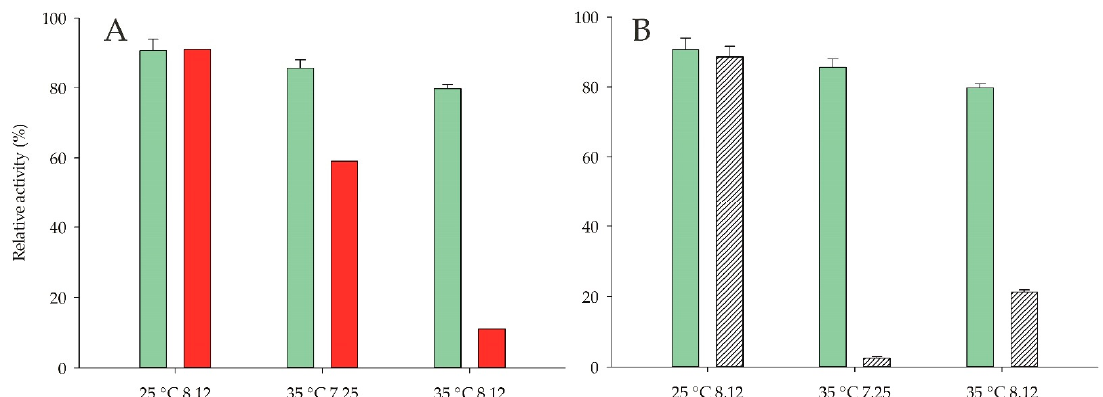
Figure 7. ( A ) Influence of pH and temperature on lipase stability. Results obtained after incubation for 1 h of proROL (black) and rROL (gray) lipase in 200 mM Tris-HCl bu ff er under di ff erent temperature and pH conditions. ( B ) proROL stability after 1 h (black) and 24 h (striped-gray) of incubation under di ff erent temperature and pH conditions in 200 mM Tris-HCl bu ff er. Activity values relative to t =